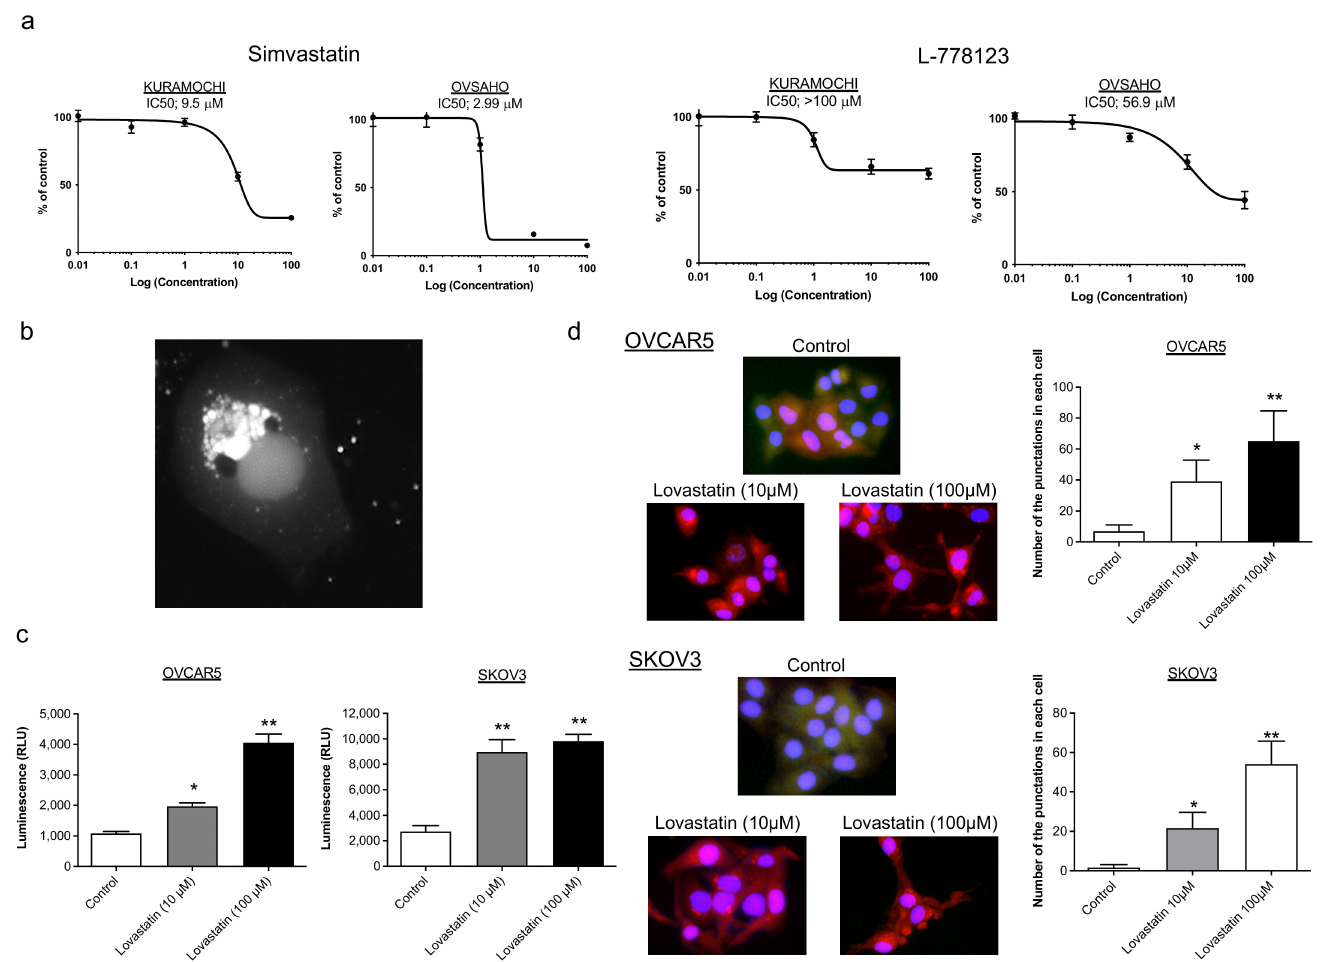
Figure 1. Exploration of new pathways and modes of action of statin. ( a ) IC50 after 72 h of incubation with simvastatin or L-778123 in KURAMOCHI and OVSAHO cells. ( b ) SKOV3 cells stably express- ing DsRed-LC3-GFP imaged under fluorescence excitation after 48 h of treatment with lovastatin. Vacuolization and fragmentation are prominent. ( c ) Caspase-3/7 activity was monitored via lumines- cence activity after 48 h of treatment with lovastatin ( n = 3). * p < 0.05, ** p < 0.01. ( d ) Representative imaging of OVCAR5 and SKOV3 merging the images of DAPI, DsRed-LC3, and GFP after 48 h of treatment with lovastatin. DAPI, nuclear staining; DsRed-LC3, red signals from DsRed-LC3B puncta; GFP, green signals from uncleaved DsRed-LC3B-GFP reporter. The number of DsRed-LC3B puncta per cell was measured for each experimental group ( n = 3). * p < 0.05, ** p <